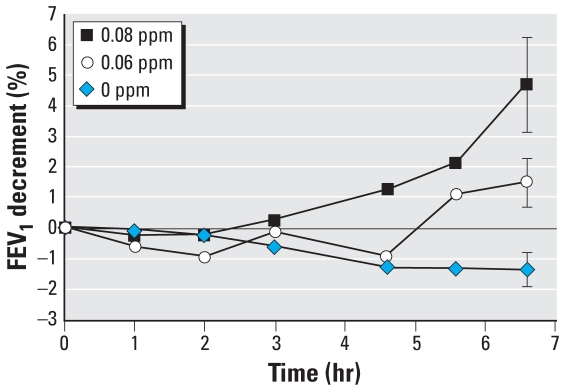
Mean FEV1 decrements as function of exposure duration and O3 concentration. Data are for constant, S-W O3 protocols in the Adams (2006) study. Error bars are the SE of responses at 6.6 hr. Adapted from Adams (2006).